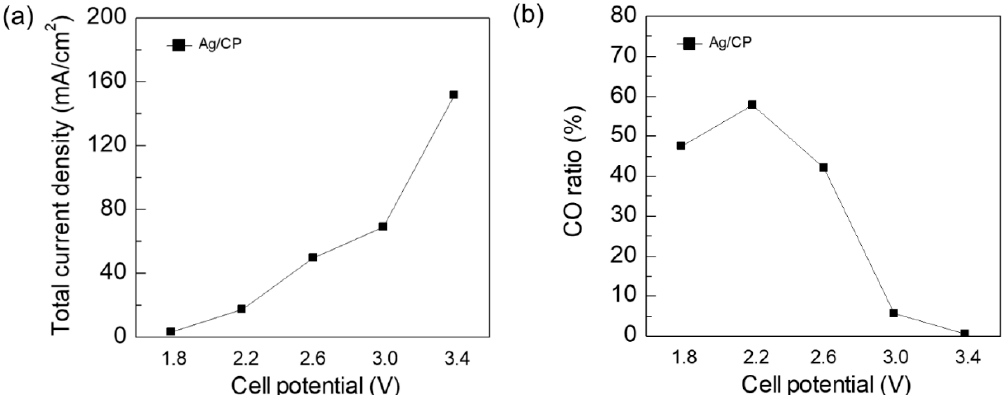
Figure 10. Performance of large area (107.44 cm 2 ) MEA-type CO 2 electrolyzer according to the applied cell potential (1.8 to 3.4 V) under pressurized condition at 4 bar; ( a ) total reduction current density and ( b ) CO ratio over other gaseous products. The 136 cm 2 large area Ag GDE fabricated by the optimized electrodeposition method (Figure 9) was cut to make 107.44 cm 2 Ag GDE. 10 mL / min of 1.0 M KHCO 3 solution and 100 mL / min of 1.0 M KOH solution were fed and circulated as the catholyte and anolyte, respectively, using flow fields at both electrodes. Gaseous CO 2 at a rate of 150 mL / min were also fed to the cathode using a separated flow field.